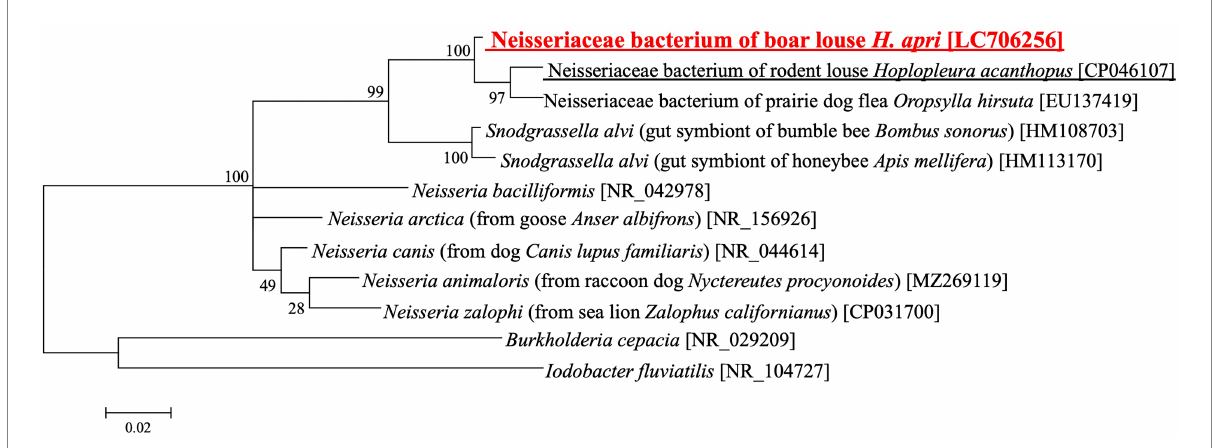
FIGURE 4 Phylogenetic placement of the Neisseria/Snodgrassella -allied bacterium of the boar louse H. apri in the Neisseriaceae based on 16S rRNA gene sequences. A maximum-likelihood phylogeny inferred from 1,063 aligned nucleotide sites is shown with bootstrap probability at each node (model: HKY + G + I). Host insect information is shown in parentheses, whereas accession number is indicated in brackets. The louse derived sequence determined in this study is highlighted in red, whereas the louse derived sequence reported in a previous study is